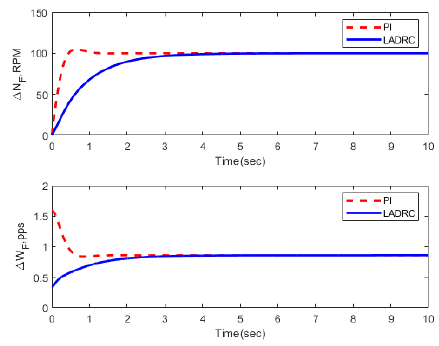
Figure 10. Step response of FC01.